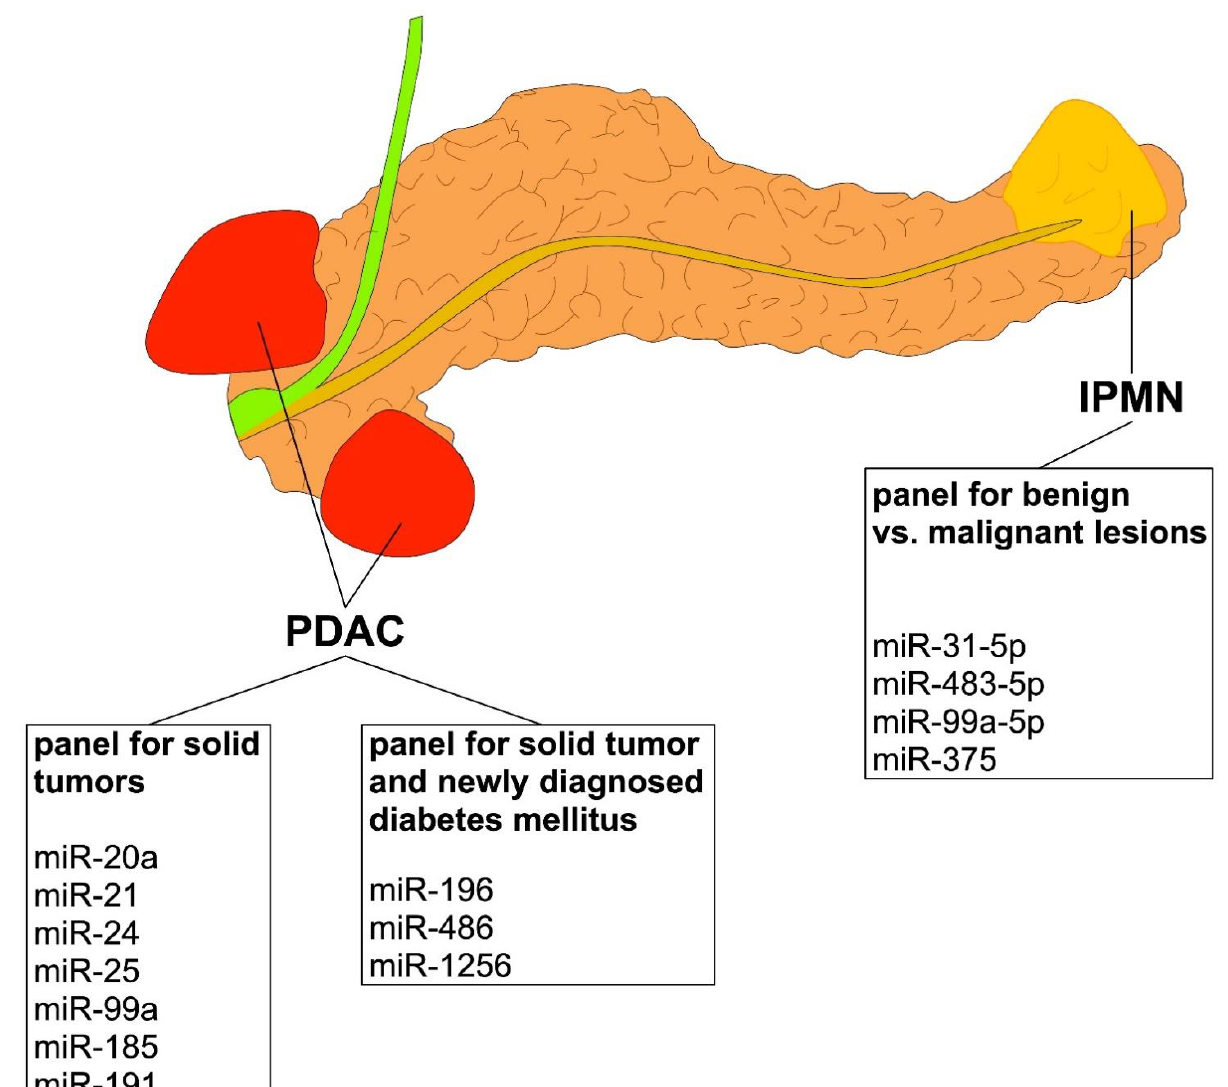
Figure 1. Overview of different panels to compare between PDAC and IPMN pancreas lesions.